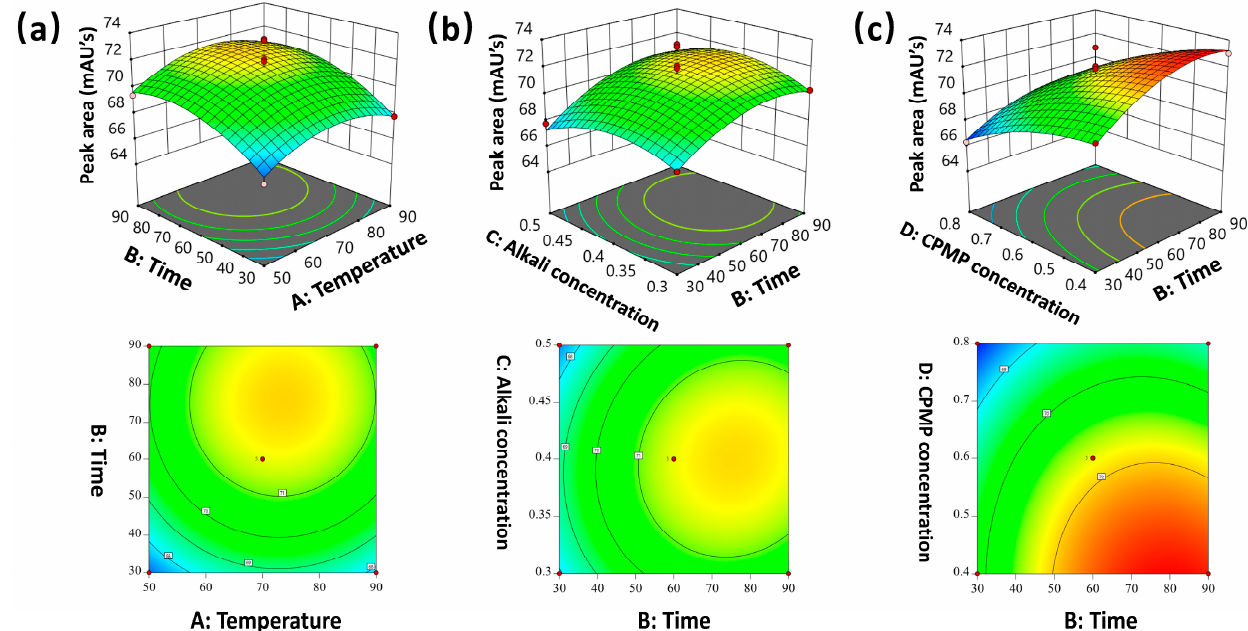
Figure 2. Response surface plots showing the effects of variables on the derivatization of CPMP. ( a ) The response surface of the impact of exaction temperature (A, °C ) and time (B, min ); ( b ) The response surface of the effects of temperature (B, min) and alkali concentration (C, mol/L); ( c ) The response surface of the impact of time (B, min) and CPMP concentration (D, mol/L). Red means the effect is the greatest; Yellow means the effect is the moderate, and the Green is the weakest.